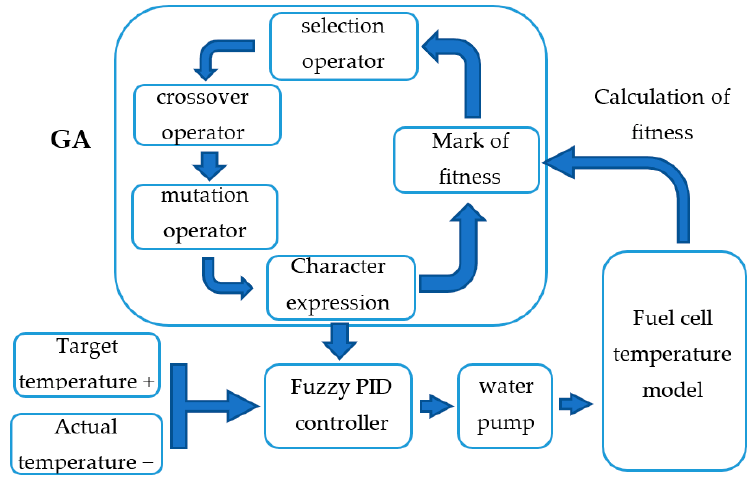
Figure 4. Fuel cell thermal management control diagram.